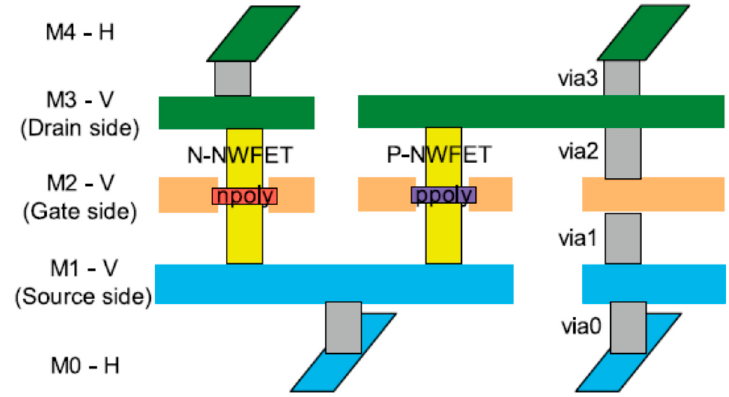
Figure 9. A design of buried interconnects for vGAAFETs [59].